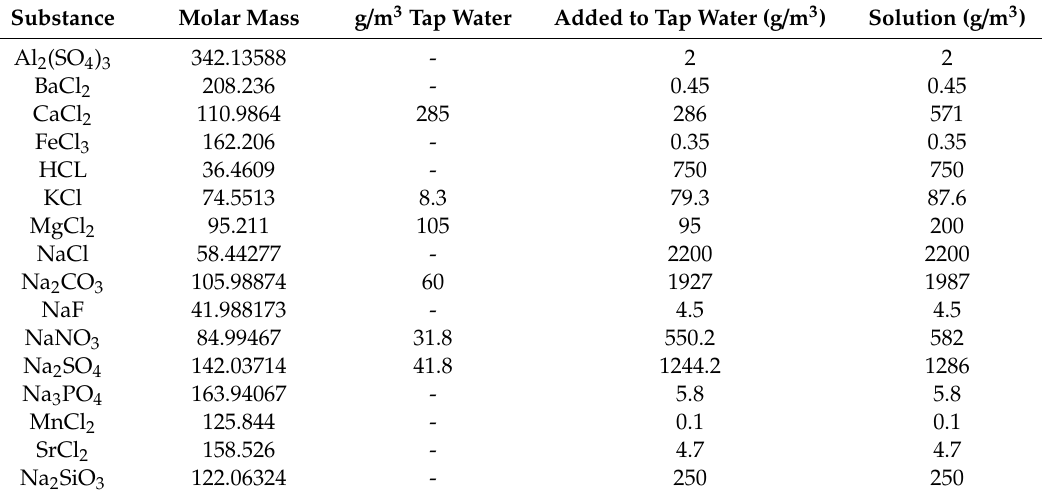
Table 1. Composition of Linz tap water and the substances added to prepare the synthetic reverse osmosis (RO) brine solution.